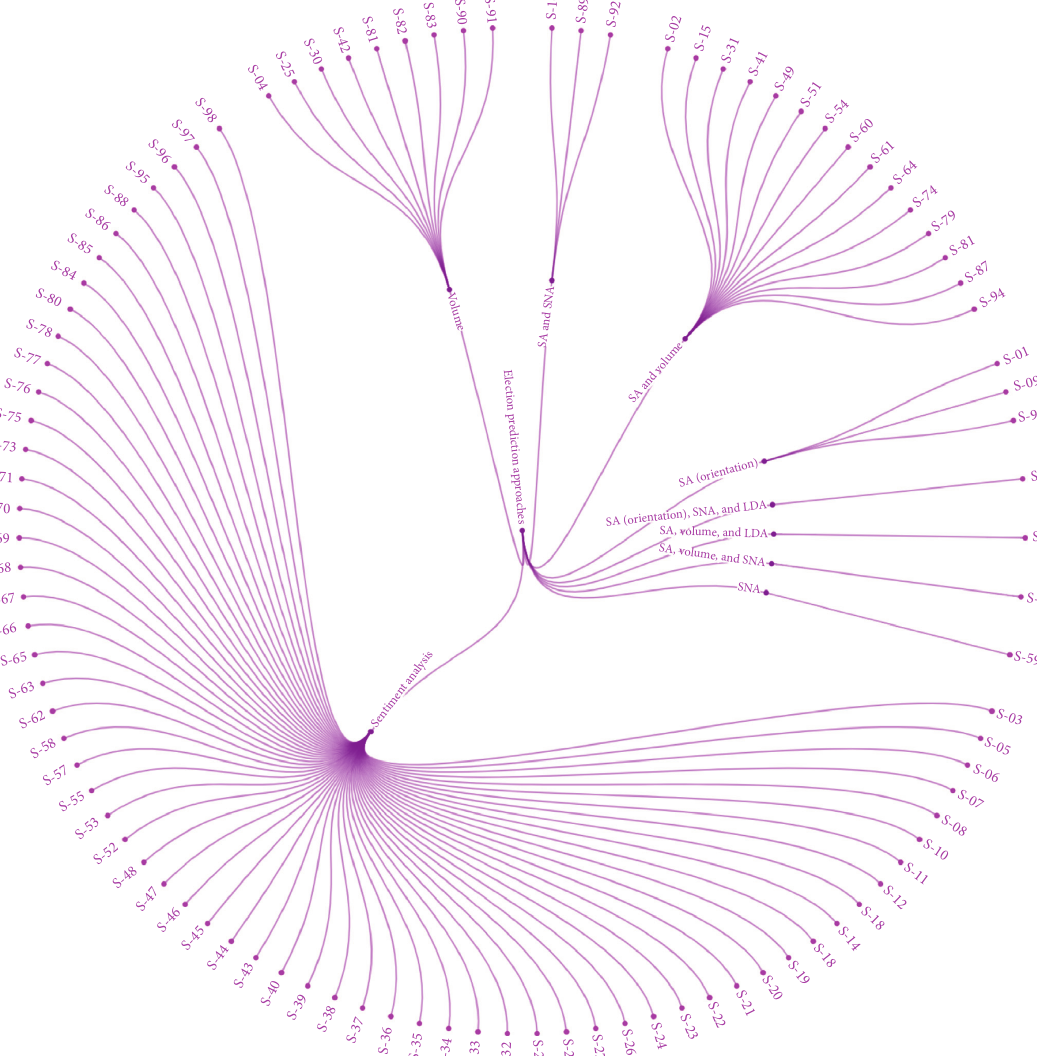
Figure 6: Election prediction approaches along with the primary studies.